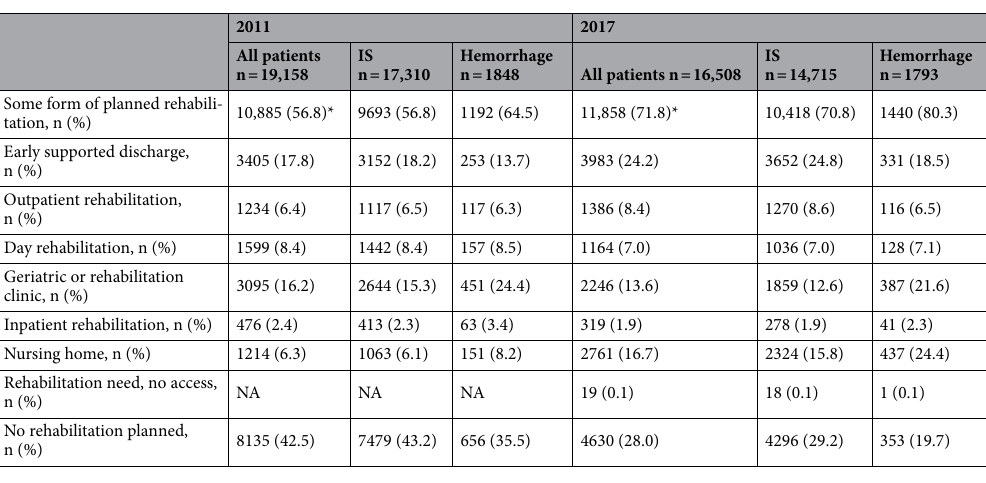
Table 2. Type of planned rehabilitation at discharge from a stroke unit. IS ischemic stroke. Significance levels for differences between the study populations from 2011 and 2017: *indicates p < 0.001. Pearson’s χ 2 test was used for